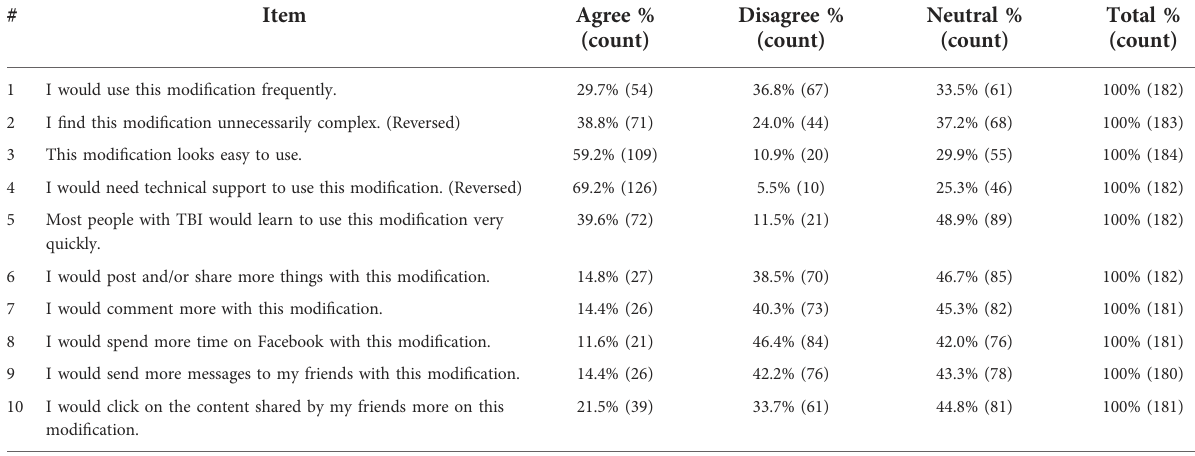
TABLE 2 Summary of participants ’ responses for all types of